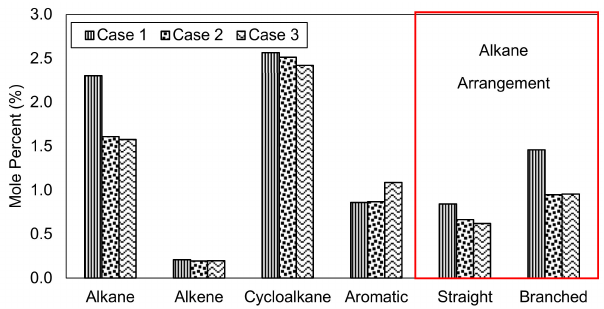
Figure 6. Remaining oil composition of CO 2 -ethanol mixture injection based on molecular struc- ture classification.